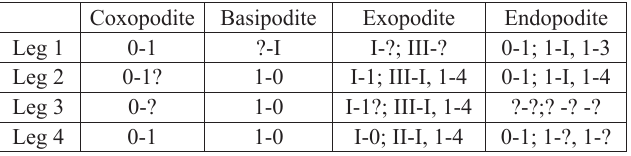
Table 3. Armature of leg 1–4 in the adult male of Apocyclops califor- nicus sp. nov. Coding system as in Table 1. 1? seta is likely